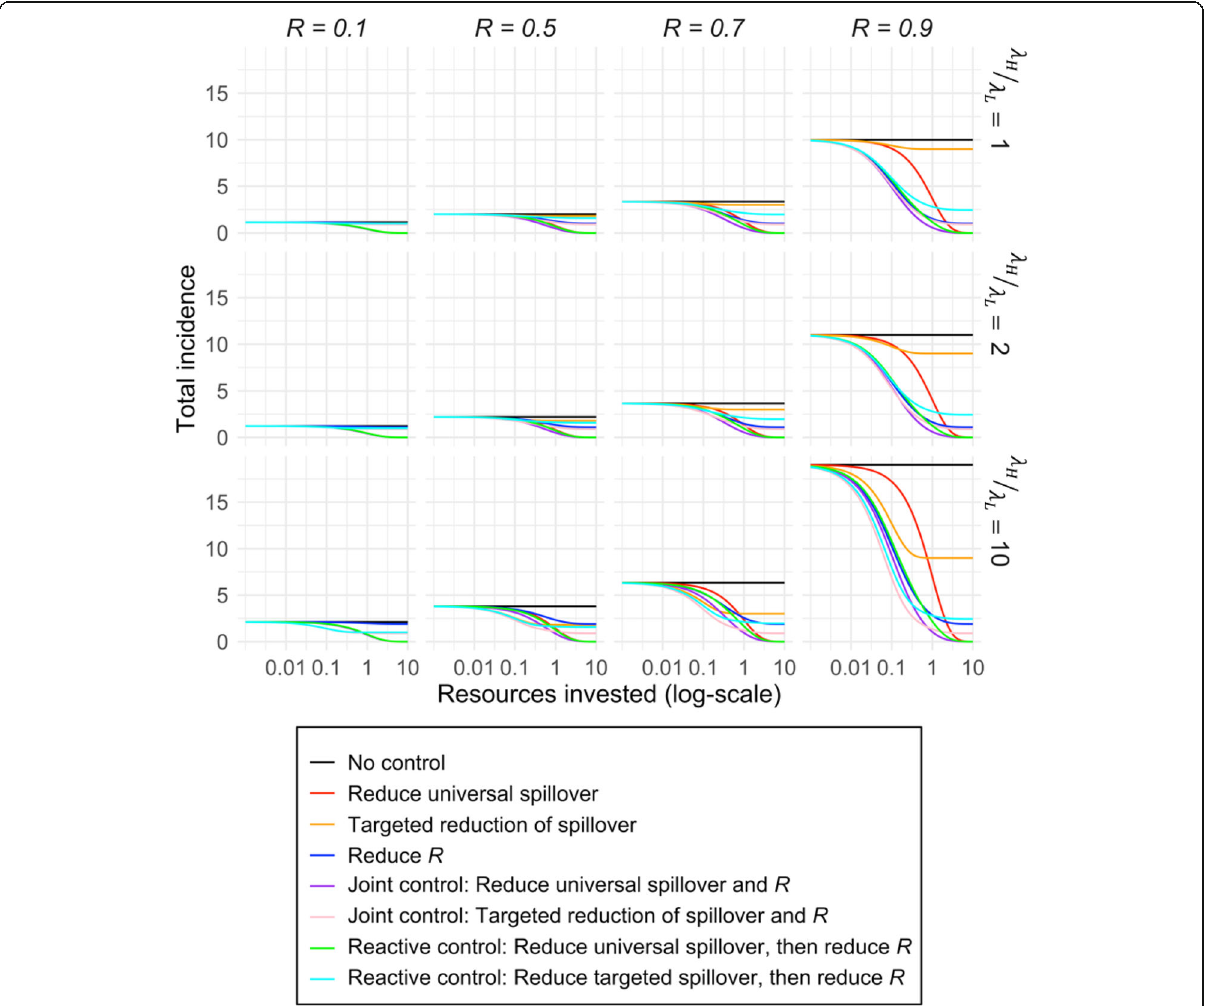
Fig. 7 Impacts of different control measures with varying resource investment on the total incidence of a zoonotic infection with R (before control) between 0 and 1 with different ratios of high-to-low spillover rates. Columns (left to right) show increasing values of R . Rows (top to bottom) represent an increasing ratio of spillover rates in high-risk versus low-risk groups ( λ H / λ L ). The black lines indicate total incidence under no control. Colored lines represent the reduction in incidence for increasing resource investment. These scenarios were explored earlier in Fig. 4 but now include the added comparison of targeted versus universal spillover control for all